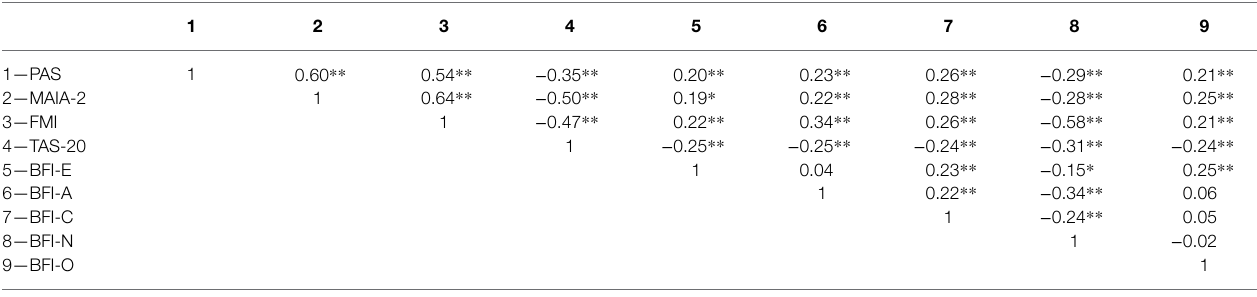
TABLE 3 | Pearson’s correlations of the total scores of measures used to assess construct